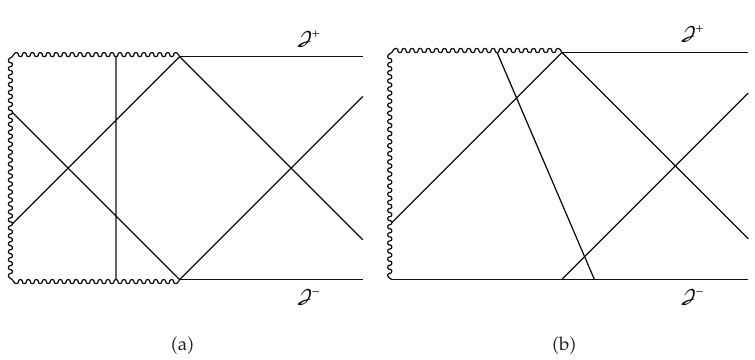
Figure 1: Penrose diagram for Λ > 0 with the FLRW universe (cid:2) a (cid:5) recollapsing; (cid:2) b (cid:5) nonrecollapsing, showing the matching surfaces and the horizons.